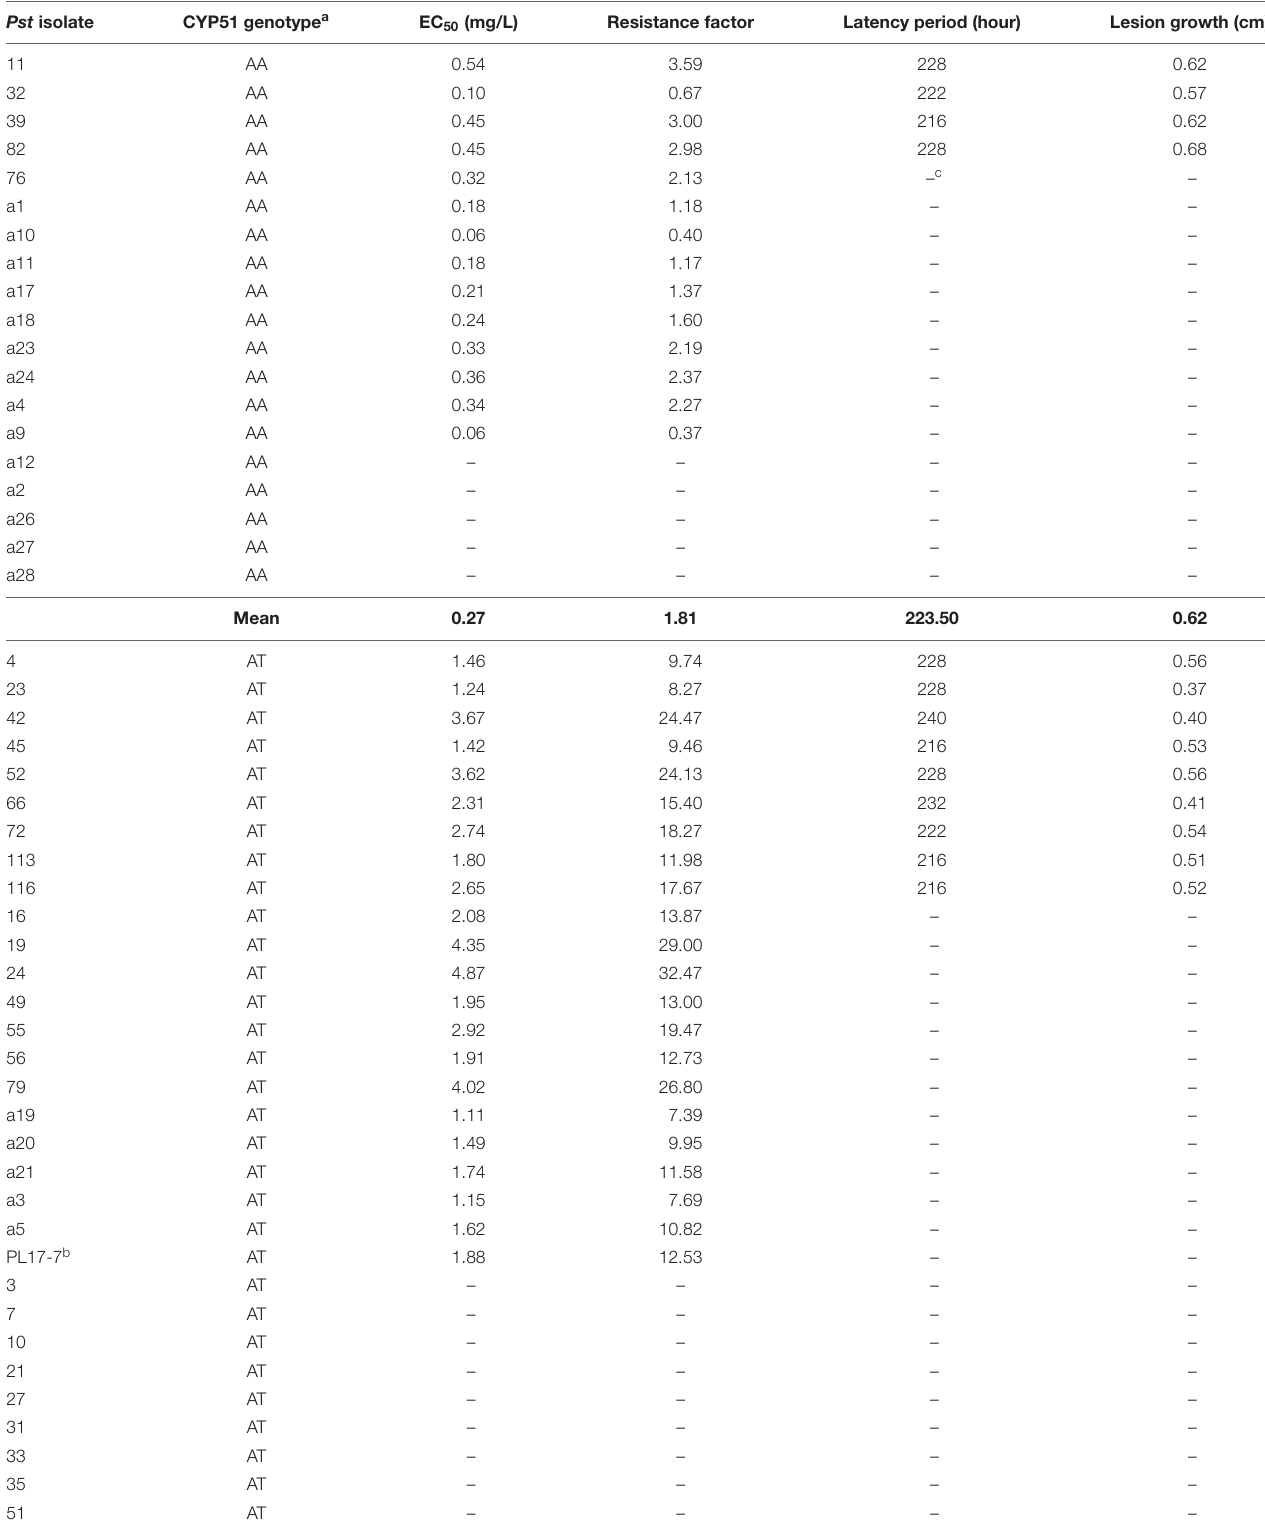
TABLE 2 | Nucleotide genotype of the CYP51 gene at the 401 position of Puccinia striiformis f. sp. tritici ( Pst ) isolates and their EC 50 value, sensitivity reduction factor, latency period, and lesion growth. Pst isolate CYP51 genotype a EC 50